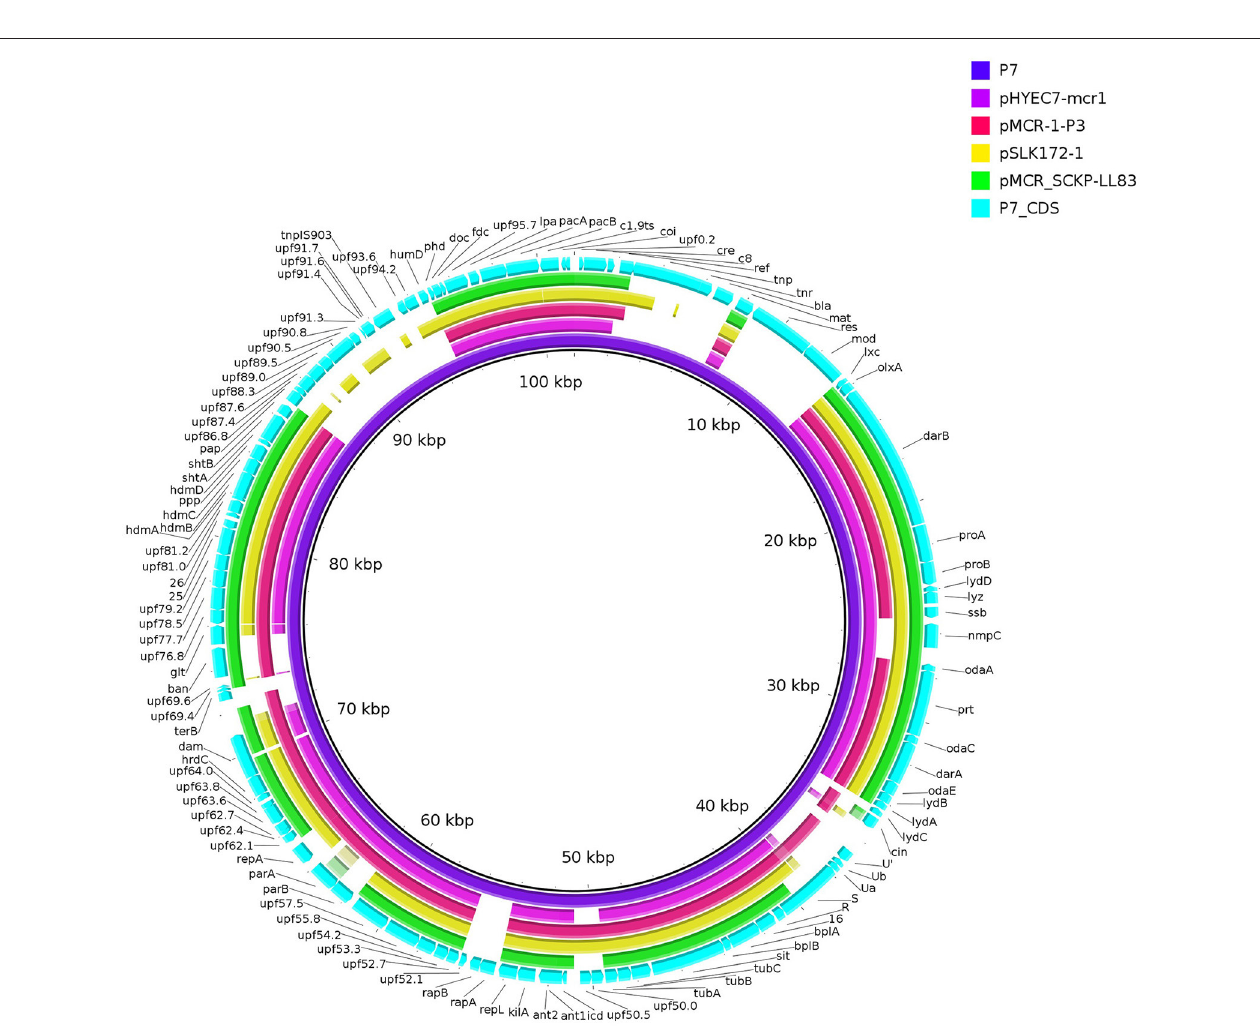
FIGURE 3 | Comparison of phage P7 and similar mcr-1 -carrying plasmids. The comparison is a pairwise BLASTn alignment performed using BRIG (Alikhan et al., 2011). Plasmids are pMCR_SCKP-LL83 (this study), pHYEC7-mcr1 (GenBank accession no. KX518745) and pSLK172-1 (GenBank accession no. CP017632) and pMCR-1-P3 (GenBank accession no. KX880944). Coding sequences (CDS) of phage P7 (GenBank accession no. AF503408) are indicated. CDS of phage P7 absent from pMCR_SCKP-LL83 or vice-verse are listed in Table S1.